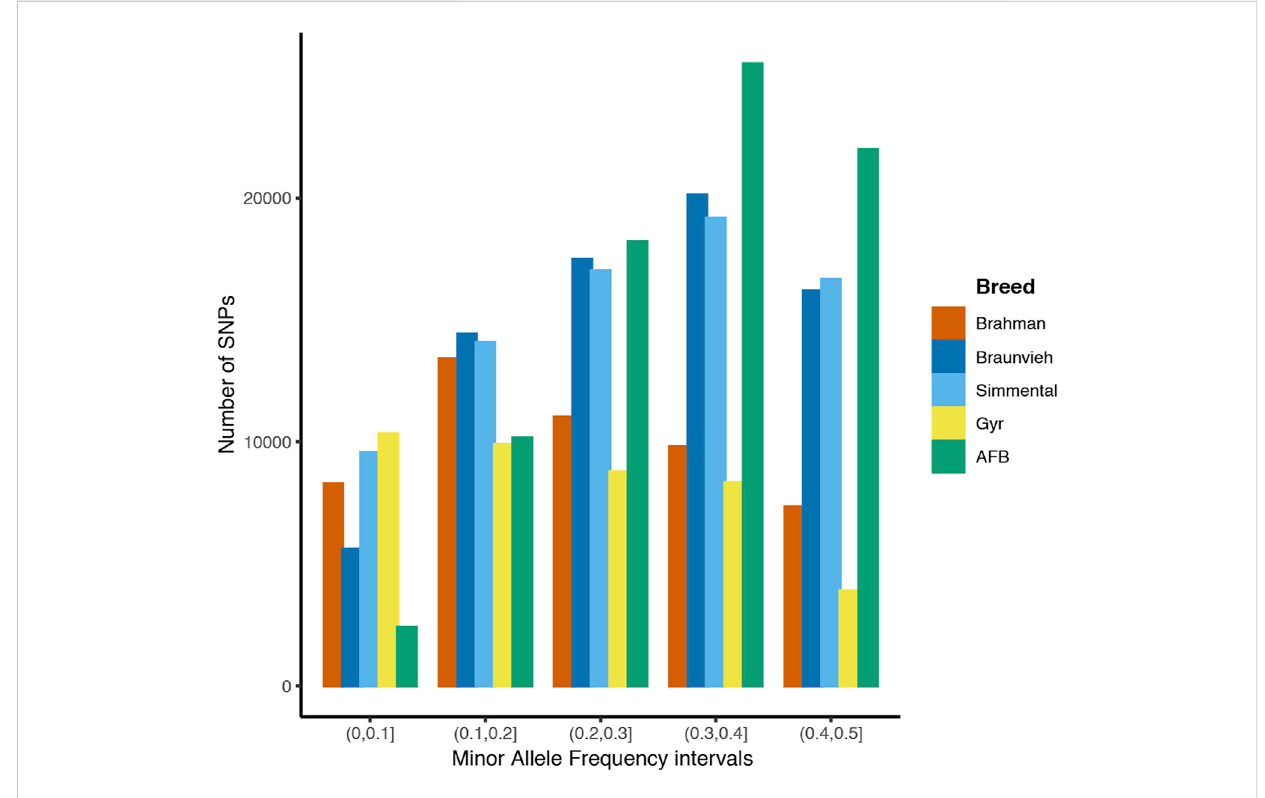
FIGURE 1 Distribution of minor allele frequency for each cattle breed.